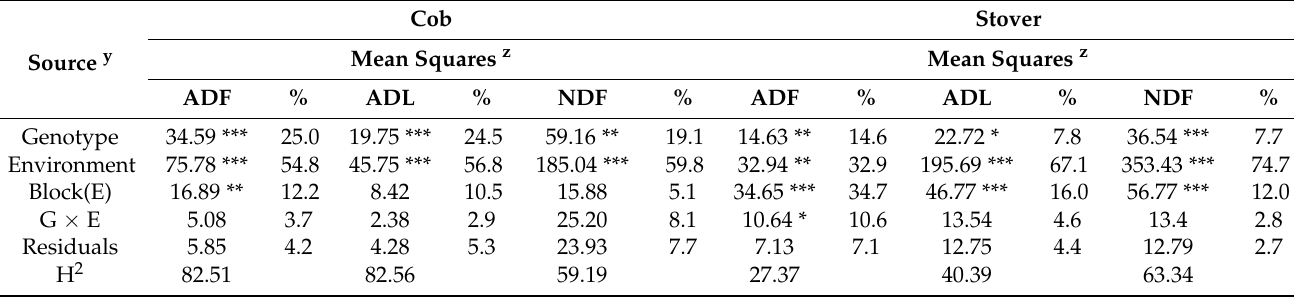
Table 3. Analysis of variance, source of variation, and broad sense heritability ( H 2 ) for acid detergent fiber (ADF), acid detergent lignin (ADL), and neutral detergent fiber (NDF) from 20 maize genotypes grown at four environments in Galicia, Spain, in 2010 and 2011.